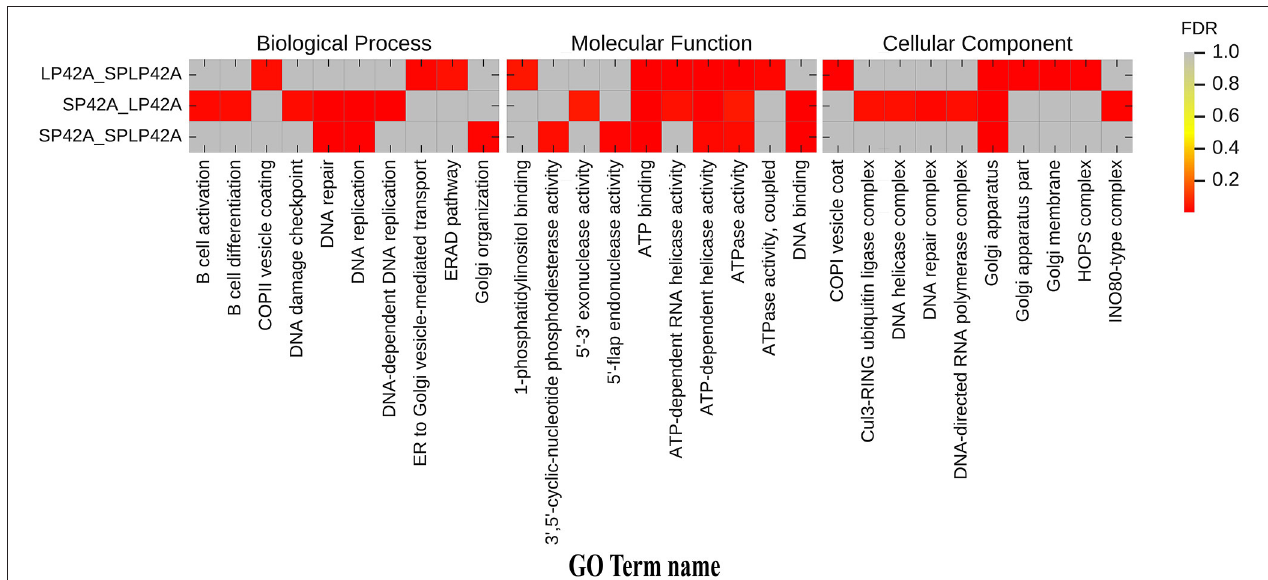
FIGURE 5 | Histogram of GO enrichment of target gene of DELs. Heat maps showing the GO items enriched in the three comparison groups of LP42 vs. SPLP42, SP42 vs. LP42 and SP42 vs. SPLP42.